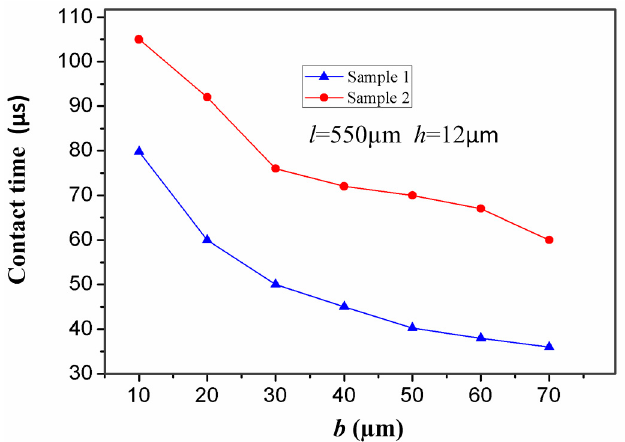
Figure 10. Dependence of contact time in samples 1 and 2 on the width ( b ) of the stationary electrode under the applied acceleration 288 g.